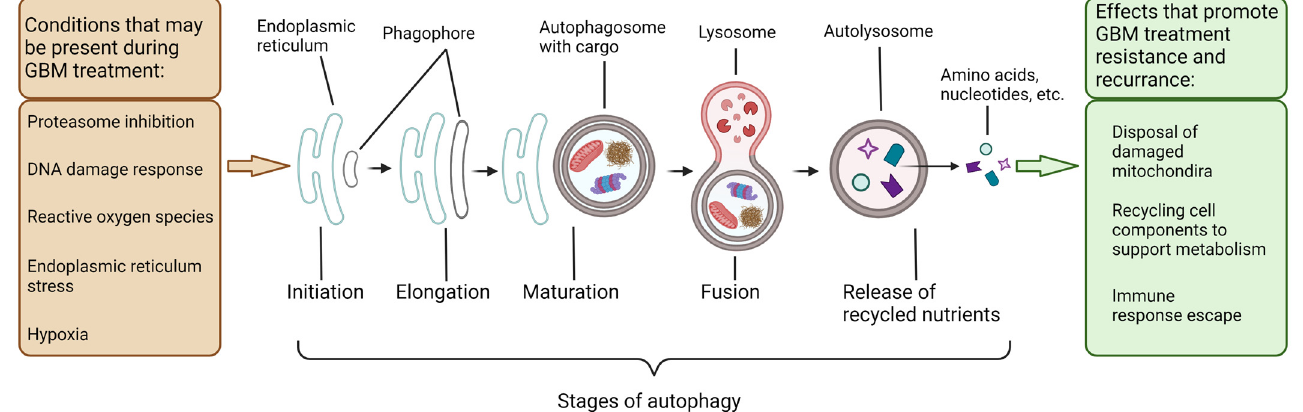
Figure 2. Conditions that lead to the inducement of autophagy in GBM and role of autophagy in treatment resistance in GBM. Conditions (e.g., hypoxia) that induce autophagy and are inherent to GBM, as well as those that may be conditional (e.g., proteasome inhibition), on specific treatments are documented here. The stages of autophagy include initiation of the phagophore at the omegasome, elongation of the double-layer phagophore membrane, sealing and maturation of the autophagosome, and fusion with the lysosome and subsequent cargo degradation with lysosomal acid hydrolases for recycling of the cellular building blocks being released back into the cytosol. Autophagy supports GBM cell survival by removing the damaged mitochondria before they can begin apoptotic signaling, mitigating the effects of hypoxia by recycling resources for the cell, and selective degradation of tumor suppressor proteins and immune signaling proteins.